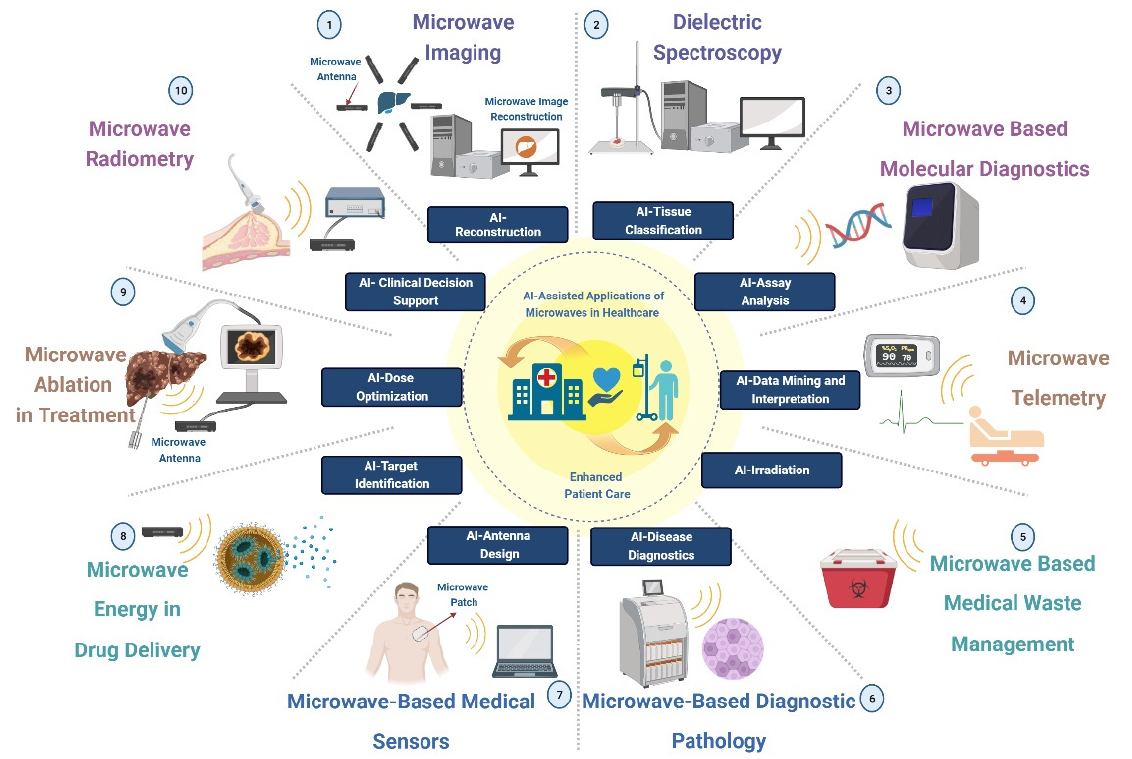
Figure 2. AI applications of microwaves in medicine to enhance patient care [8].